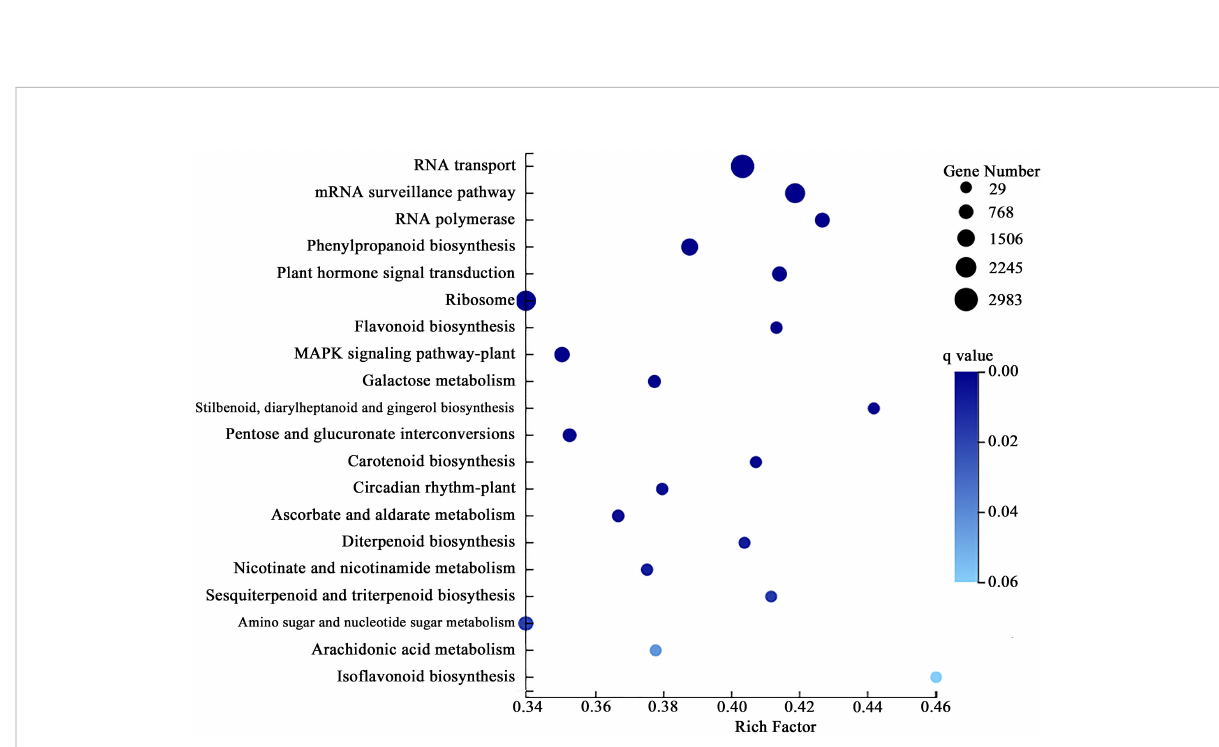
FIGURE 3 Kyoto encyclopedia of genes and genomes (KEGG) enrichment analysis of differential expression genes (DEGs) in the roots of P. crinitum under Pb Stress.